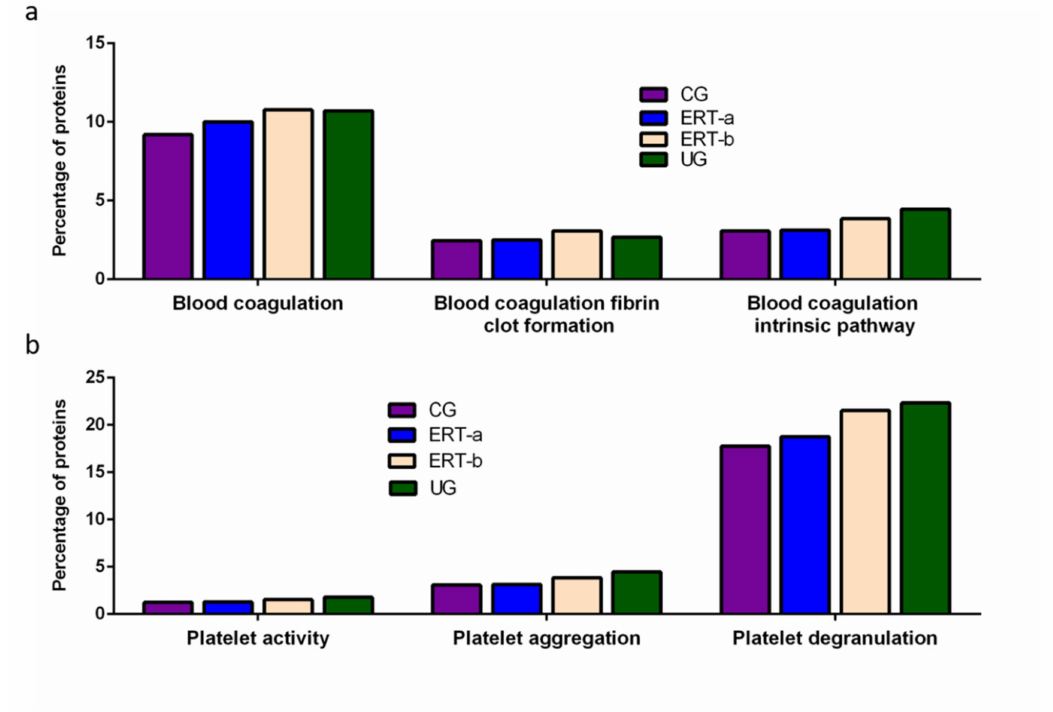
Figure 3. Functional enrichment analysis using FunRich. Proteins identified in each the different groupswere submitted to molecular functional analysis according to their involvement inhemostasis ( a ) and platelet function ( b ). CG, control group; ERT-a, patients sampled before ERT; ERT-b, patients sampled 24 h after ERT; UG, untreated group. Proteins listed for qualitative proteomic analysis appear in Supplementary Table